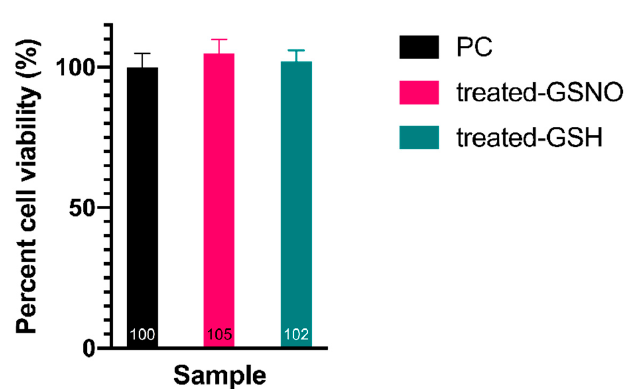
Figure 6. Percent cell viability of Human Dermal Fibroblasts (HDF) cells when exposed to 1 mM GSNO for 24 h at 37 ° C, 5% CO 2 assessed by the assessed by the CTB assay. Data points represent the mean of n ≥ 7 data points ± standard deviation. One-way ANOVA confirmed that all three sample sets did not statistically differ at a 99% CI.